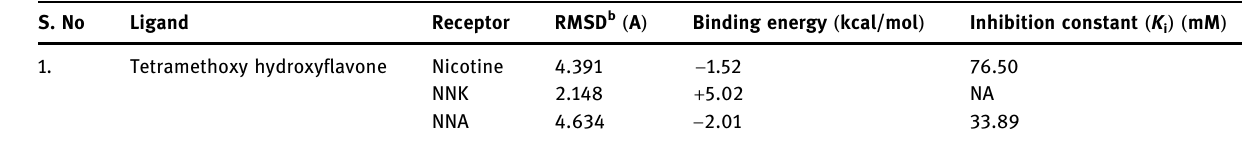
Table 1: Docking results of tetramethoxy hydroxy fl avone with three carcinogens from cigarette smoke S.